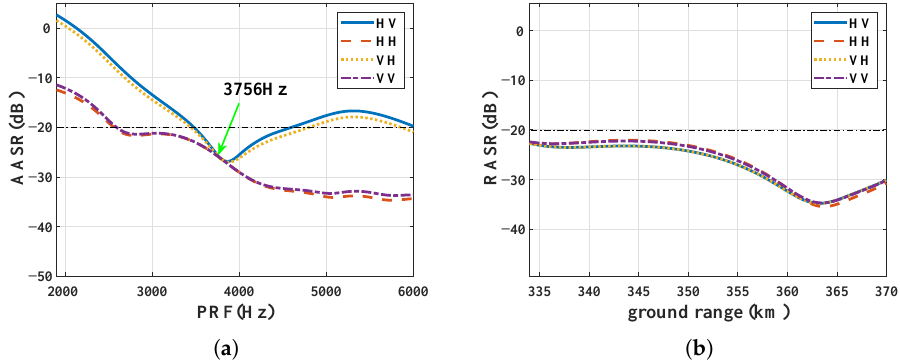
Figure 8. AASR and RASR performance of system #2 by JOSA method. ( a ) the AASR versus PRF. ( b ) the RASR (PRF = 3756 Hz) versus the ground range.